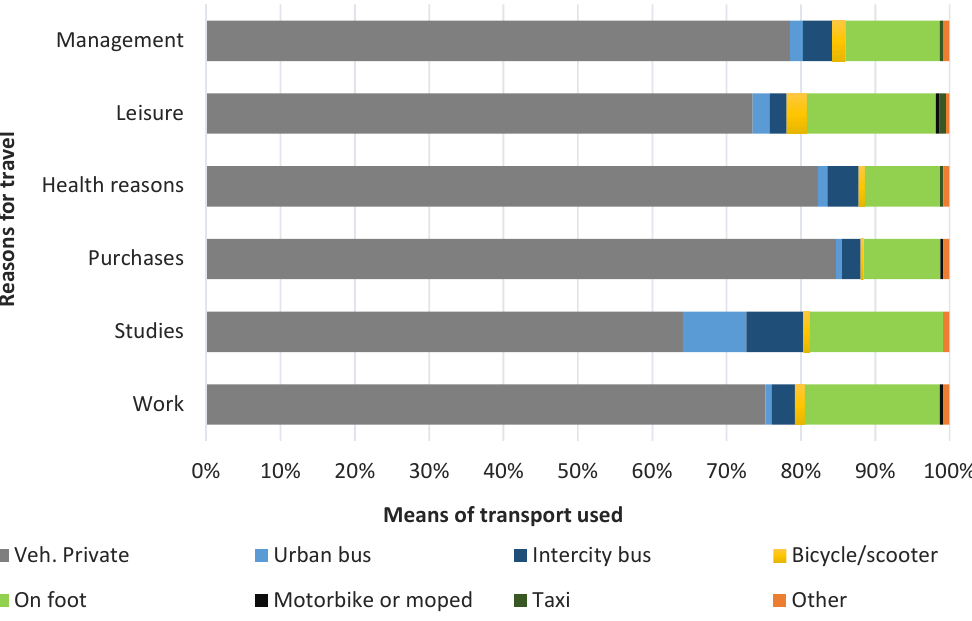
Figure 7. Means of transport used according to travel reasons.